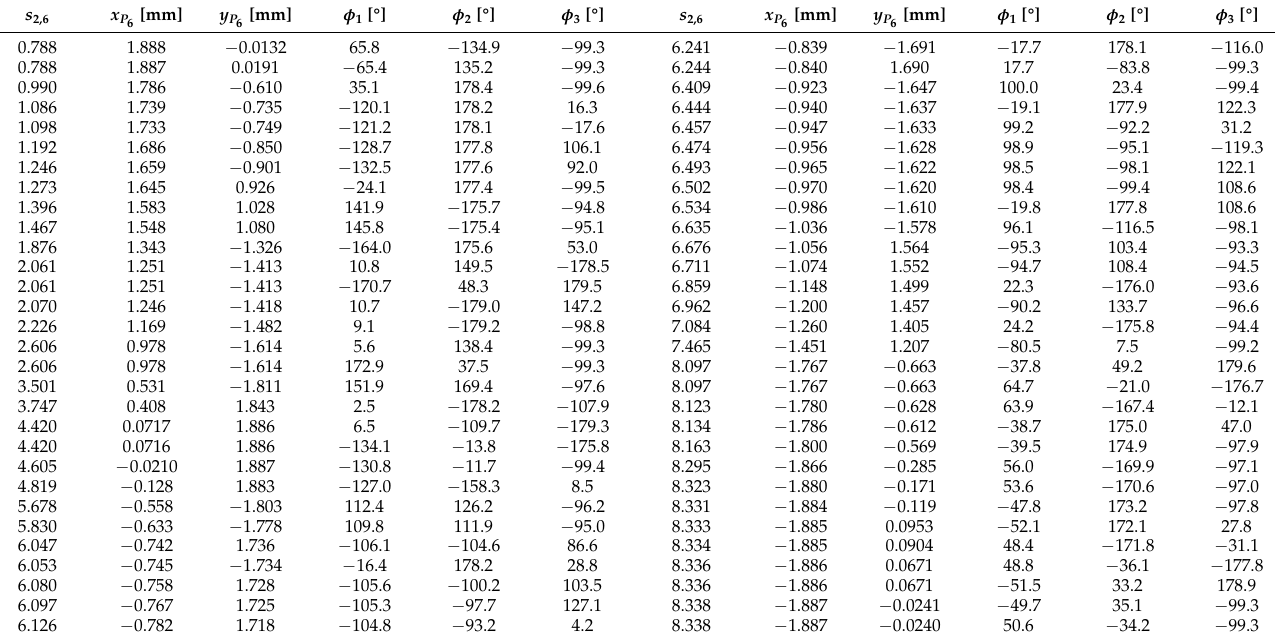
Table 6. All 60 possible solutions of the DKP for the 5-RR architecture in Table 3. Notice that some solutions are very close in terms of s 2,6 (and are thus indistinguishable from each other without providing more significant digits that those which can be displayed in the available space), yet lead to clearly different